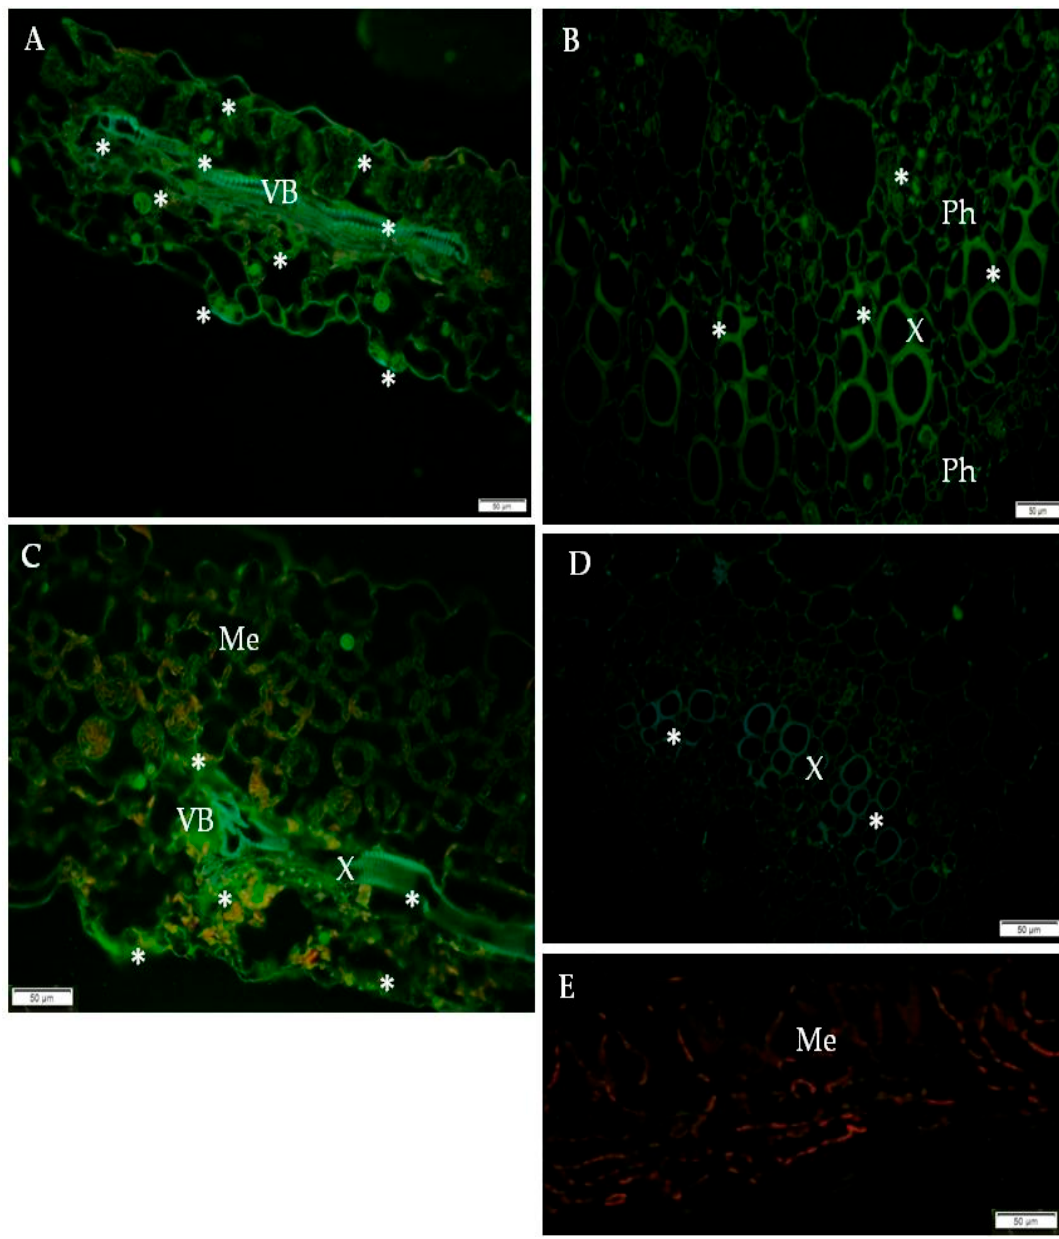
Figure 3. Fluorescence detection of RbohD protein in a compatible interaction of potato Irys plants with PVY NTN . ( A ) RbohD signal (*) in vascular bundle, stomata in epidermis and mesophyll 7 days after PVY NTN -inoculation. ( B ) Green fluorescence of RbohD in vascular tissues 7 dai. ( C ) Green fluorescence of RbohD in necrotizing area of the vascular bundle with the epidermis 21 dai. ( D ) RbohD signal in xylem tracheary elements in mock inoculated potato Irys plant. ( E ) Lack of green fluorescence signal (negative control) in susceptible reaction potato Irys when primary antibodies were omitted. Bar 50 µm. Ep—epidermis, Me—mesophyll, St—stomata, VB—vascular bundle.